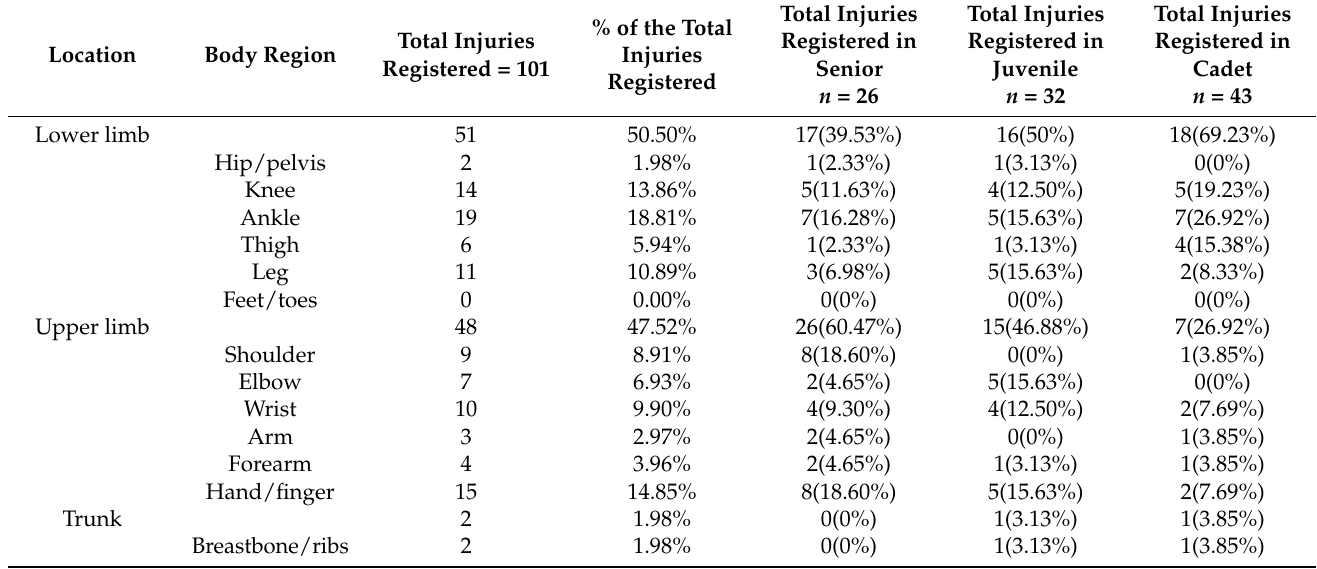
Table 3. Anatomical location of the registered